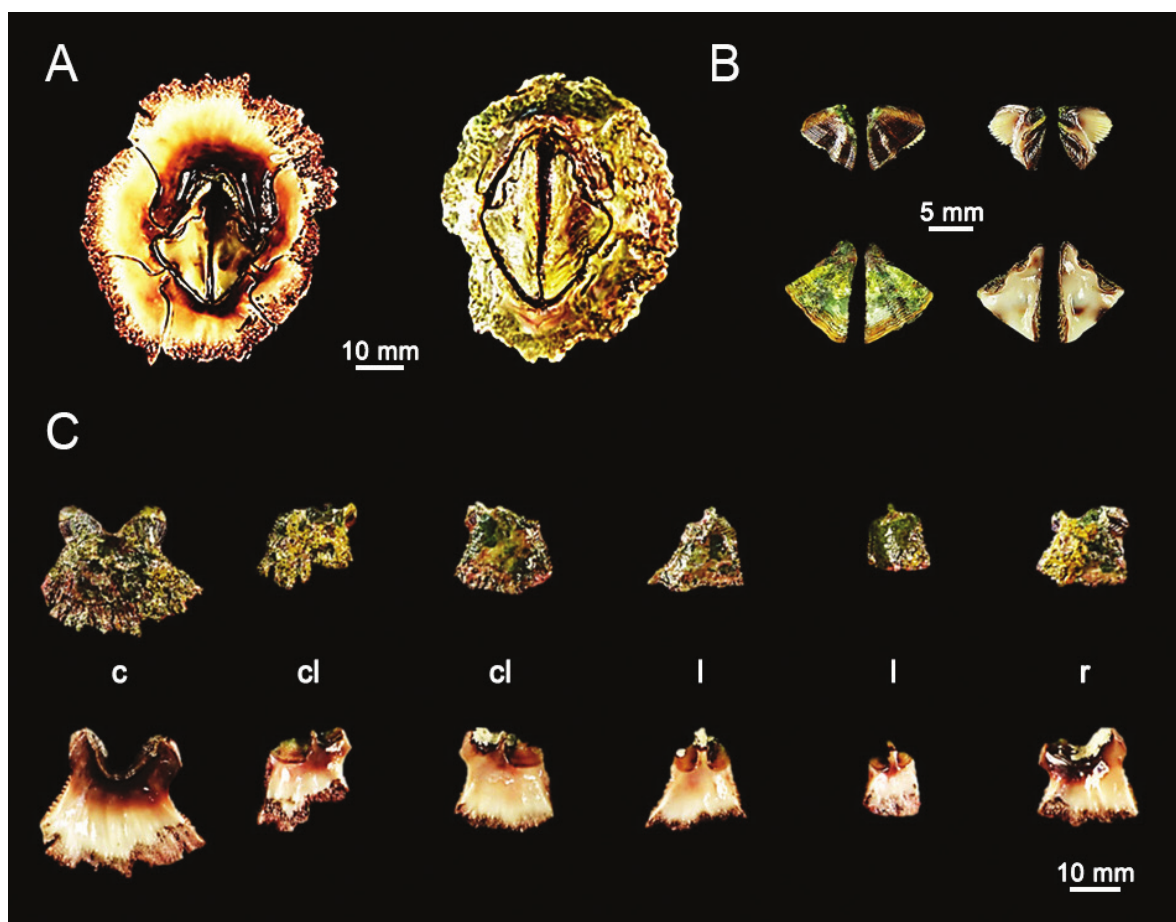
Figure 4. Euraphia hembeli collected from Na Tai beach, Phang-nga (BUU16.CH.CH01). A. Dorsal and ventral view of external shell, B. External (left panel) and internal (right panel) view of tergum (upper panel) and scutum (lower panel), C. External (upper panel) and internal (lower panel) view of shell plates. Abbreviations: c, carina; cl, carinal latus; l, latus; r,